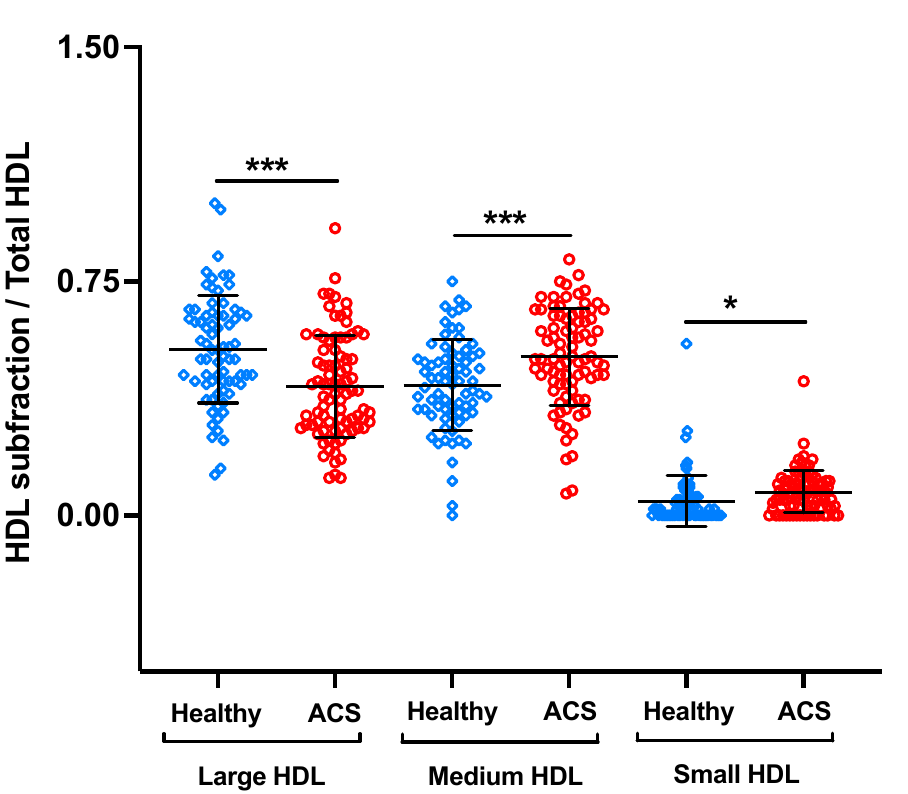
Figure 5. Lipoprotein subclass distribution of HDL from ACS patients compared to healthy control subjects. HDL subclass distribution analysis was determined using the Quantimetrix ® Lipoprint ® HDL System. *** p < 0.0003 and * p < 0.01.